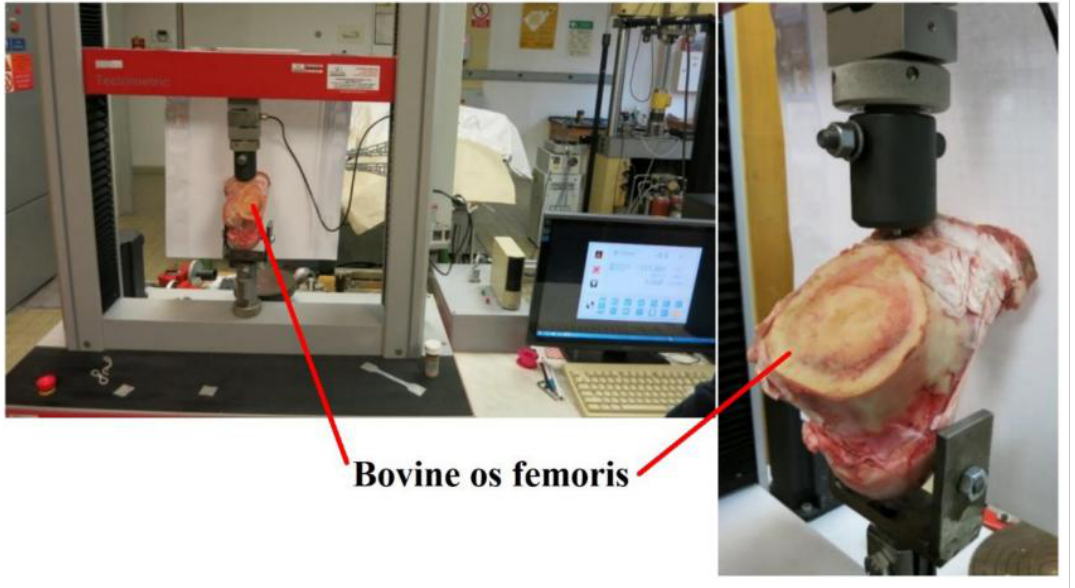
Figure 12. Biomechanics of bovine os femoris , bone screw application and the pull-out